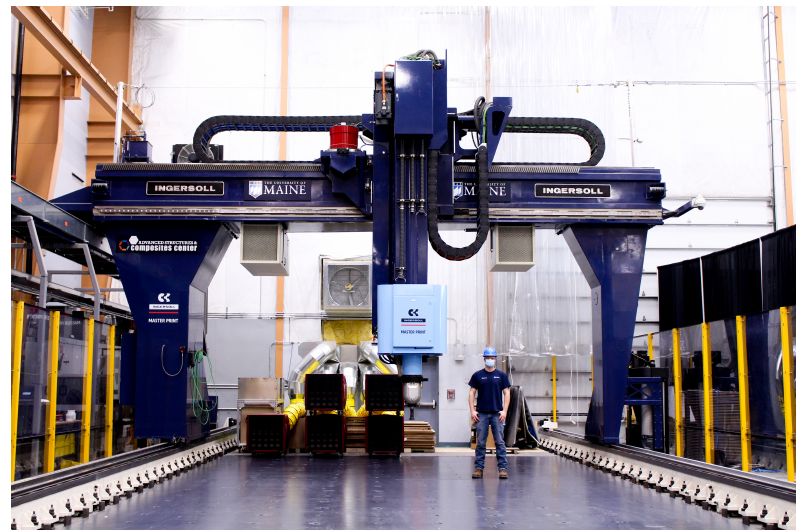
Figure 1. Image comparing the scale of the Masterprint 3X located at the University of Maine with an operator.